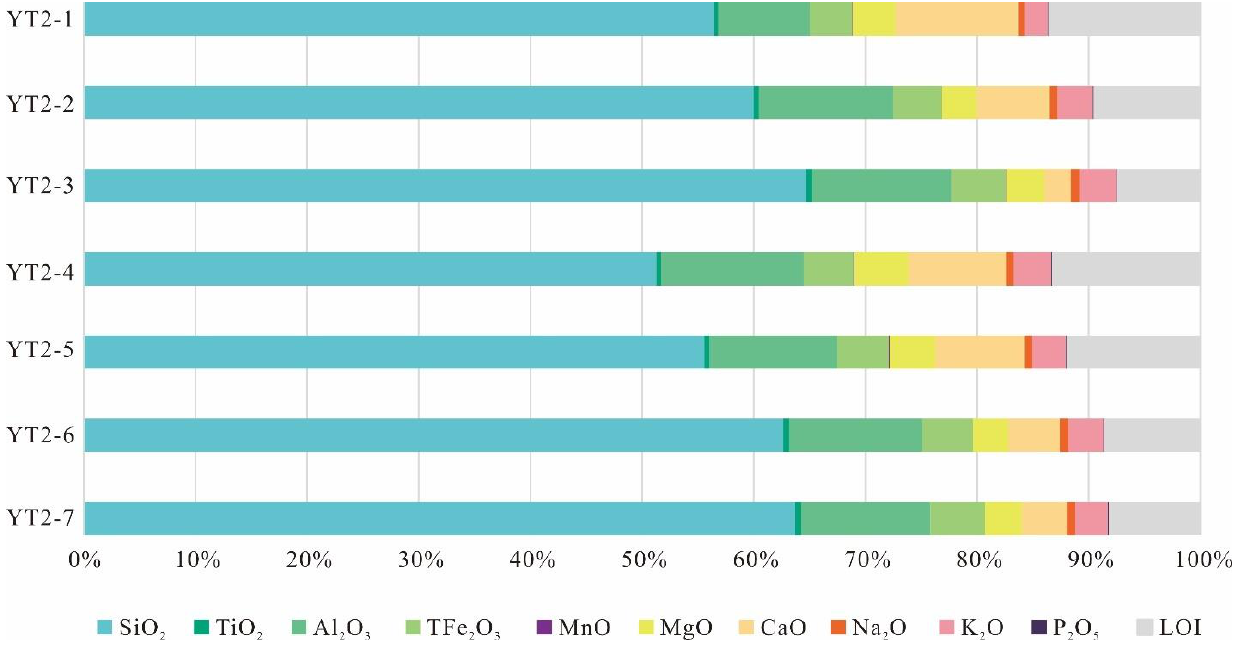
Figure 6. Diagram of major elements content.